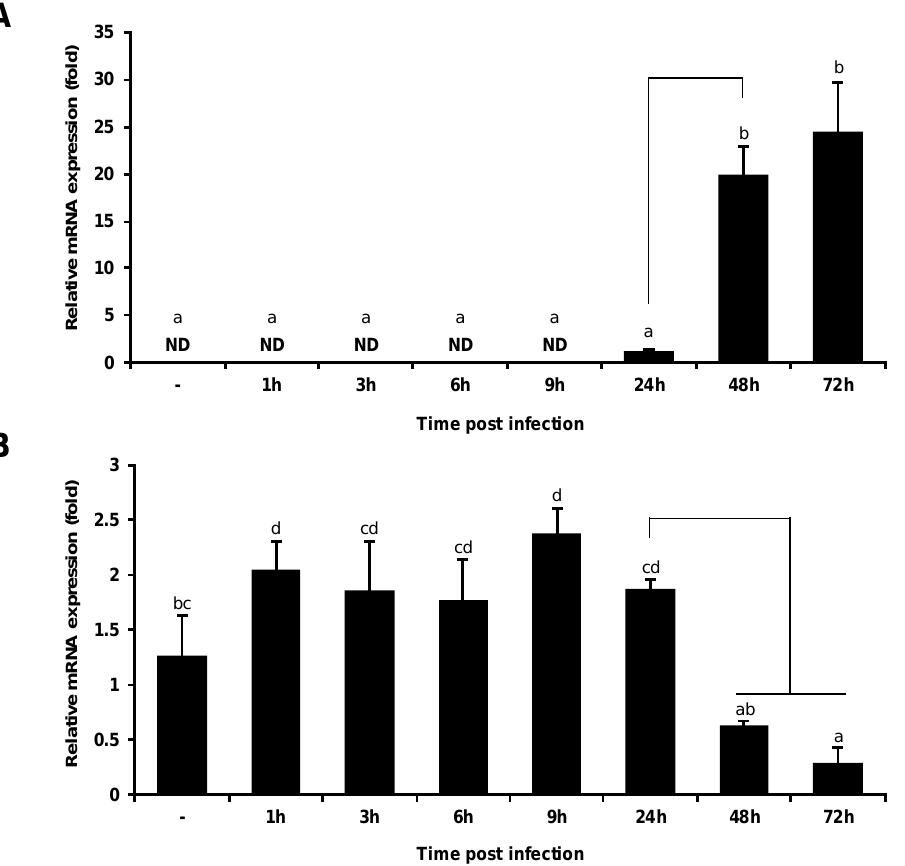
Figure 5. PoMaf1 expression was reduced by VHSV infection in flounder HINAE cells in a time- dependent manner. ( A ) Transcript level of VHSV glycoprotein (G) in HINAE cells infected with VHSV. ND, not detected. ( B ) Transcript level of PoMaf1 in HINAE cells infected with VHSV. HINAE cells were infected with VHSV at a MOI of 0.5 and samples were collected at the indicated time points. Transcript levels were analyzed by quantitative real-time PCR and are expressed as fold relative values over the control (0 h) normalized to 18S rRNA. Means and standard deviations of three independent replicates are shown. Means with the same superscript letter are not significantly different ( p ≤ 0.05).